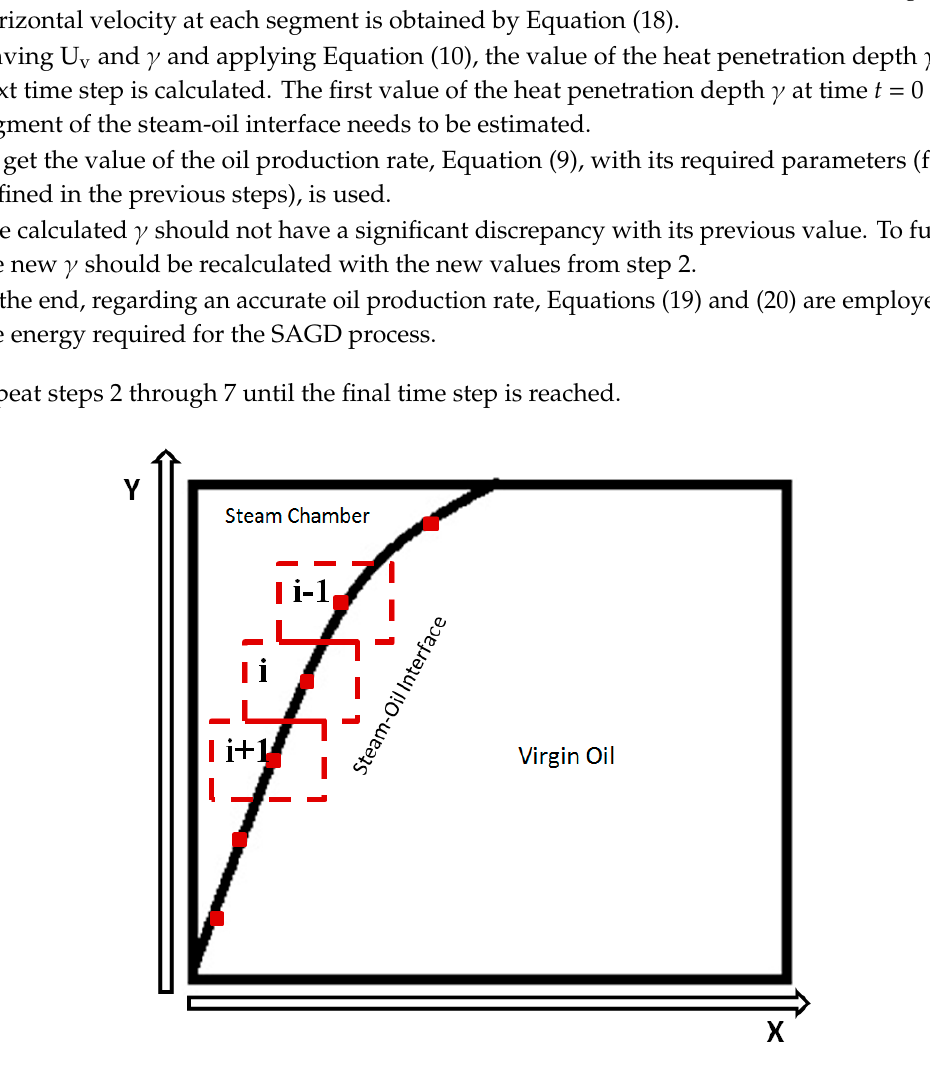
Figure 4. Division of the interface into even subdivisions. The black line is the steam-oil interface and each segment on the line is separated by the red bubbles.